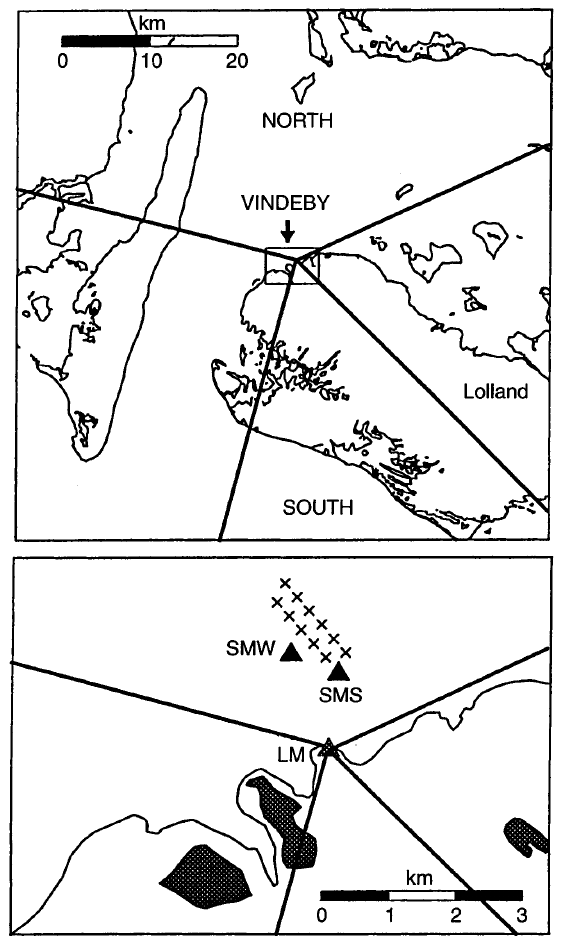
Fig. 1. Map of the Vindeby monitoring location. The crosses indicate the location of wind turbines. The measurement masts are indicated by the solid triangles and the identifiers: LM = land mast, SMS = sea mast south, SMW = sea